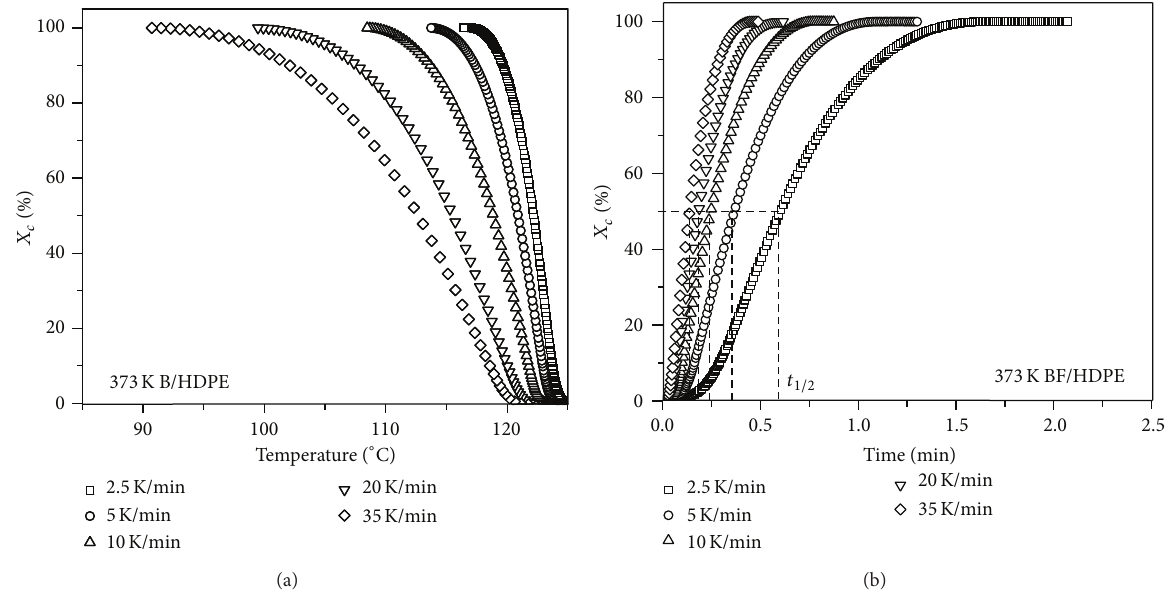
Figure 3: (a) Curves of relative crystallinity for HDPE/heat-treated BF composites (BF with a heat-treatment temperature of 373 K) versus temperature. (b) Curves of relative crystallinity for HDPE/heat-treated BF composites (BF with a heat-treatment temperature of 373 K) versus time.